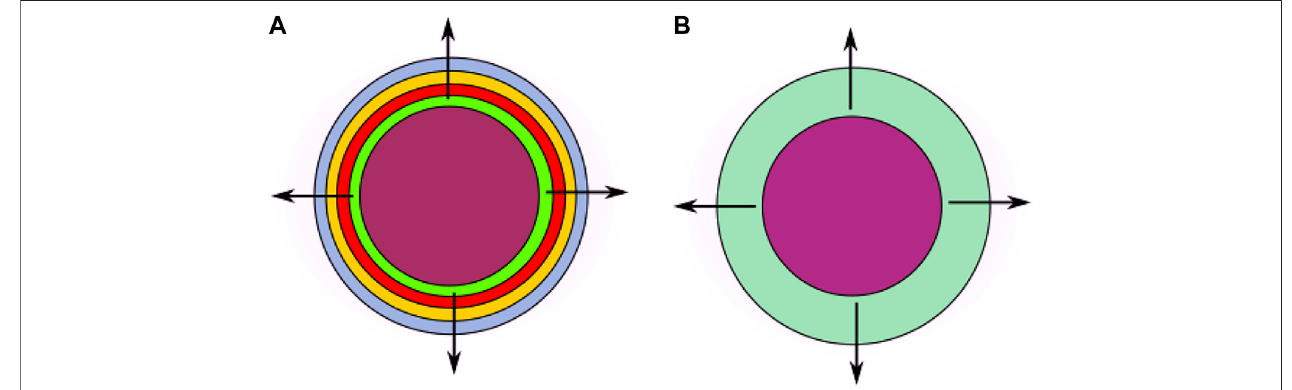
FIGURE 1 | Diagram of the cross section of a spherical two-layer system based on an internal core and concentric LbL coating (left, (A) ). With reference to their releasing properties, the enveloping layers can be assimilated to a unique equivalent shell having averaged characteristics (right, (B) ) ( fi gures not to scale).